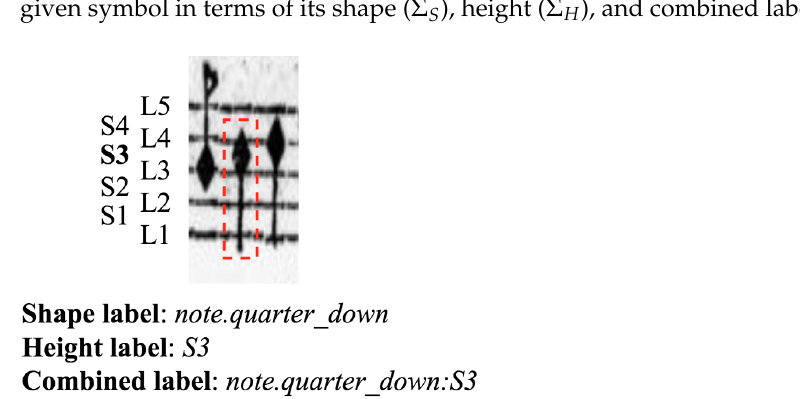
Figure 1. Agnostic representation of a handwritten music symbol, showing its shape, height, and combined labels. Note that L n and S n , respectively, denote the line or space of the staff on which the symbol may be placed, which refers to its height